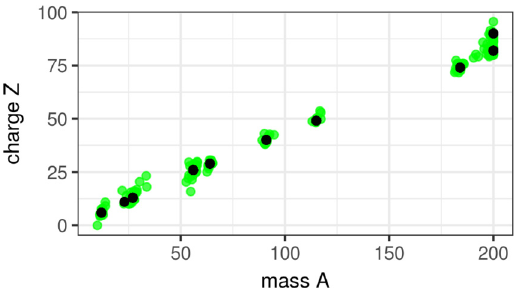
Fig. 1. Dispersion of the pseudo-inputs during the optimization procedure shown in the ( A , Z )-projection. The black points are the initial positions and the green points the fi nal positions of